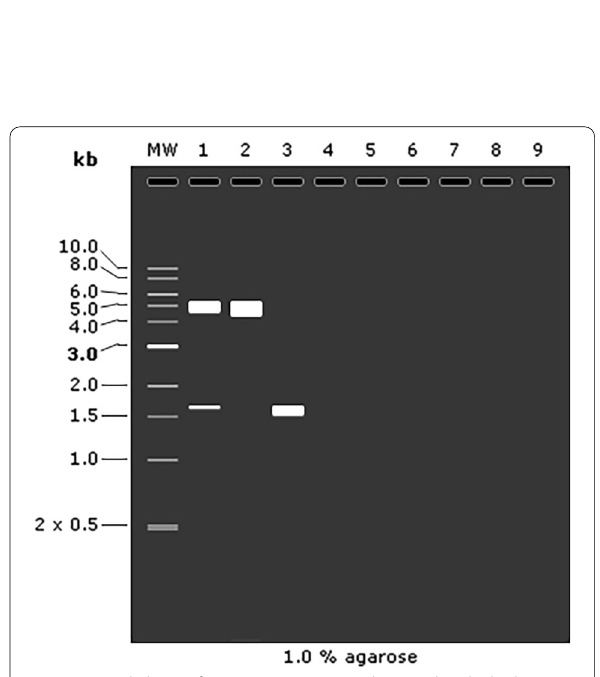
Fig. 5 Virtual clone of a vaccine construct designed with dual digestion. Line1: Digestive structure of vaccine (vaccine and vector) with two enzymes XhoI and BamHI; line2: digestion of two enzymes, vector pET-28a ( ); line 3: digestion of two enzymes, incert (designed + vaccine)